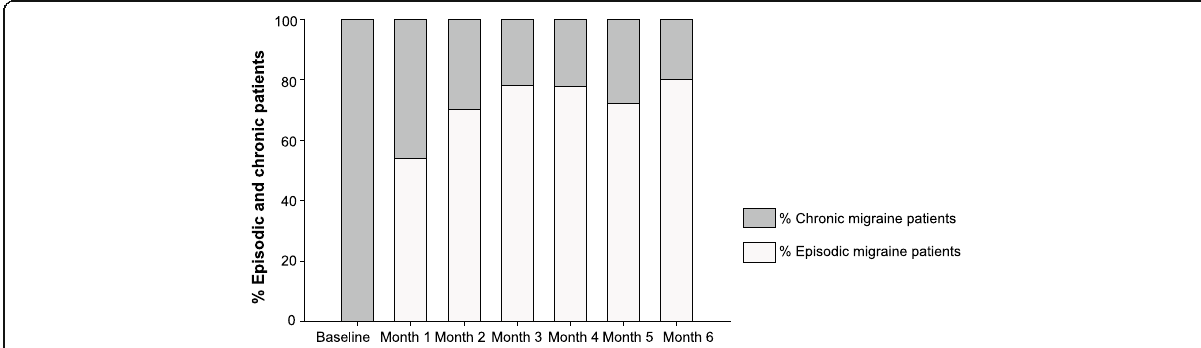
Fig. 4 Percentage of chronic and episodic migraine patients: Percentage of patients who converted into an episodic migraine pattern (< 15